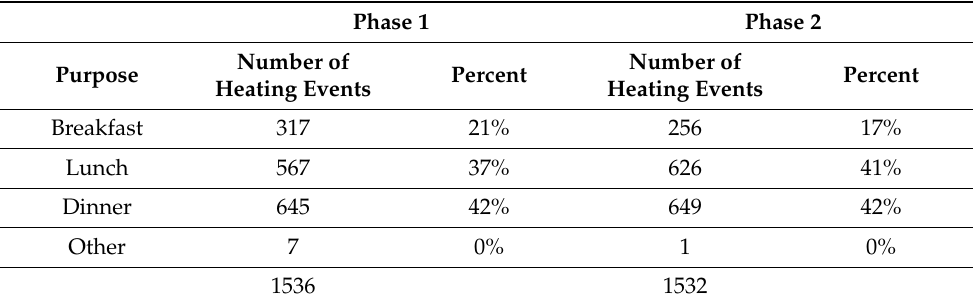
Table 7. Comparing heating purpose events before and after introducing EPCs.